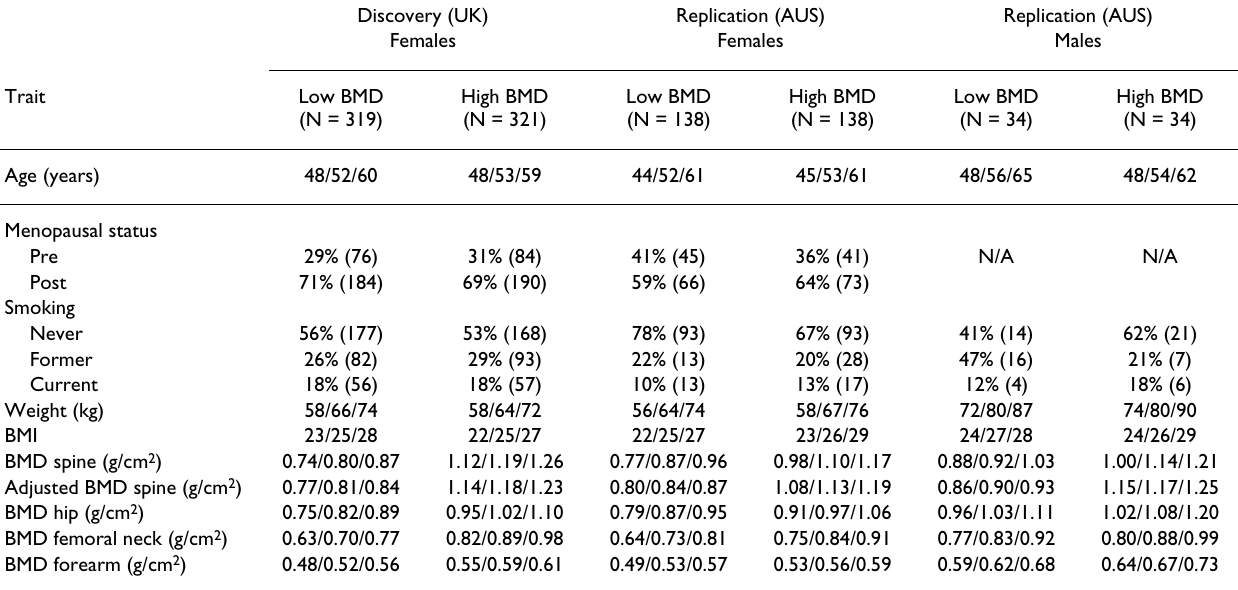
Table 1: Characteristics of subjects in the groups selected for low and high lumbar spine bone mineral